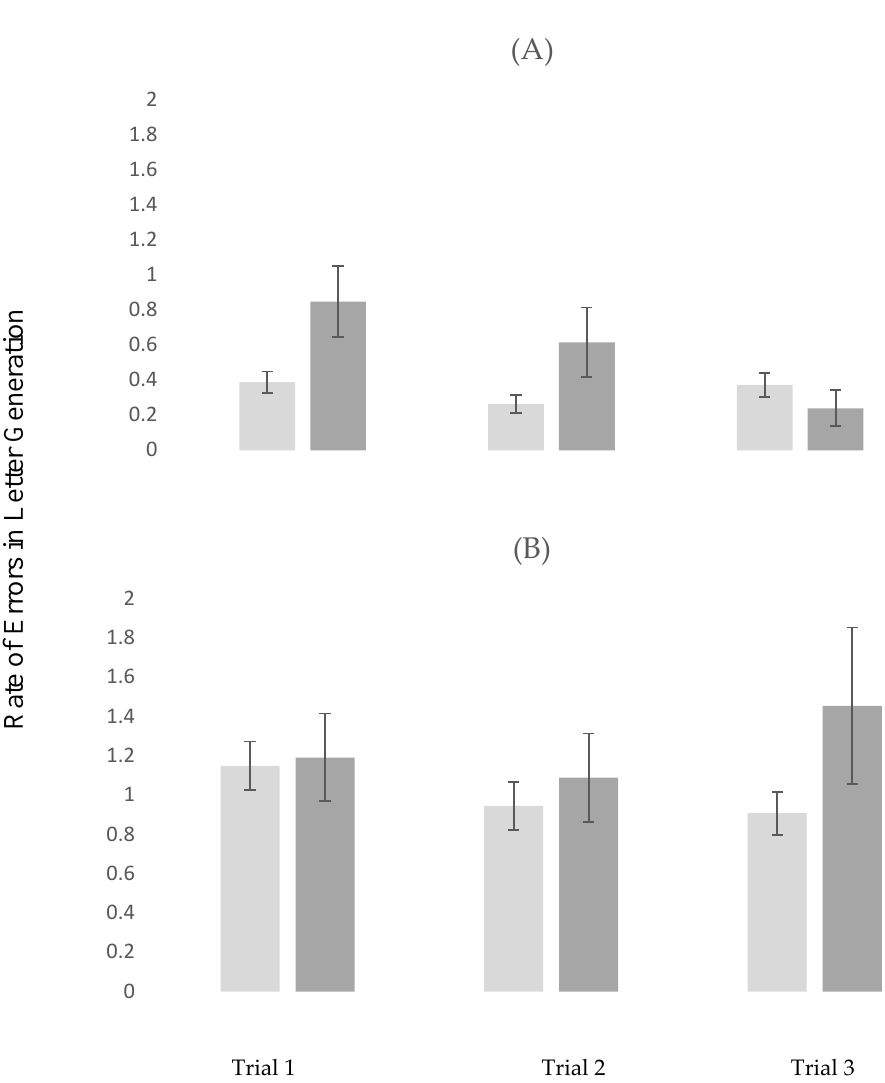
Figure 4. Changes in errors in letter generation across repeated trials stratified by task conditions in in MCI and control participants. Light Grey: Control Participants; Dark Grey: MCI Participants;